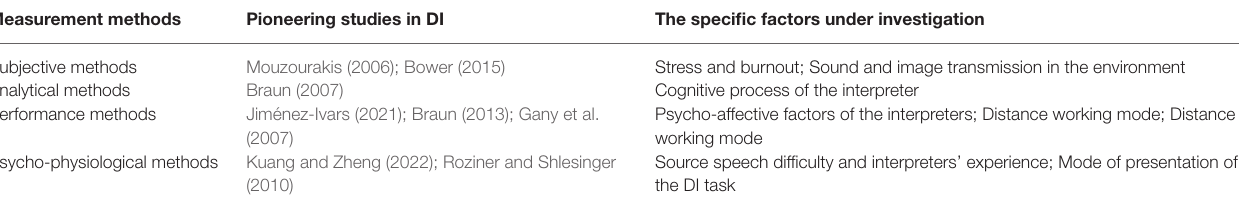
TABLE 2 | Measurement methods of cognitive load in